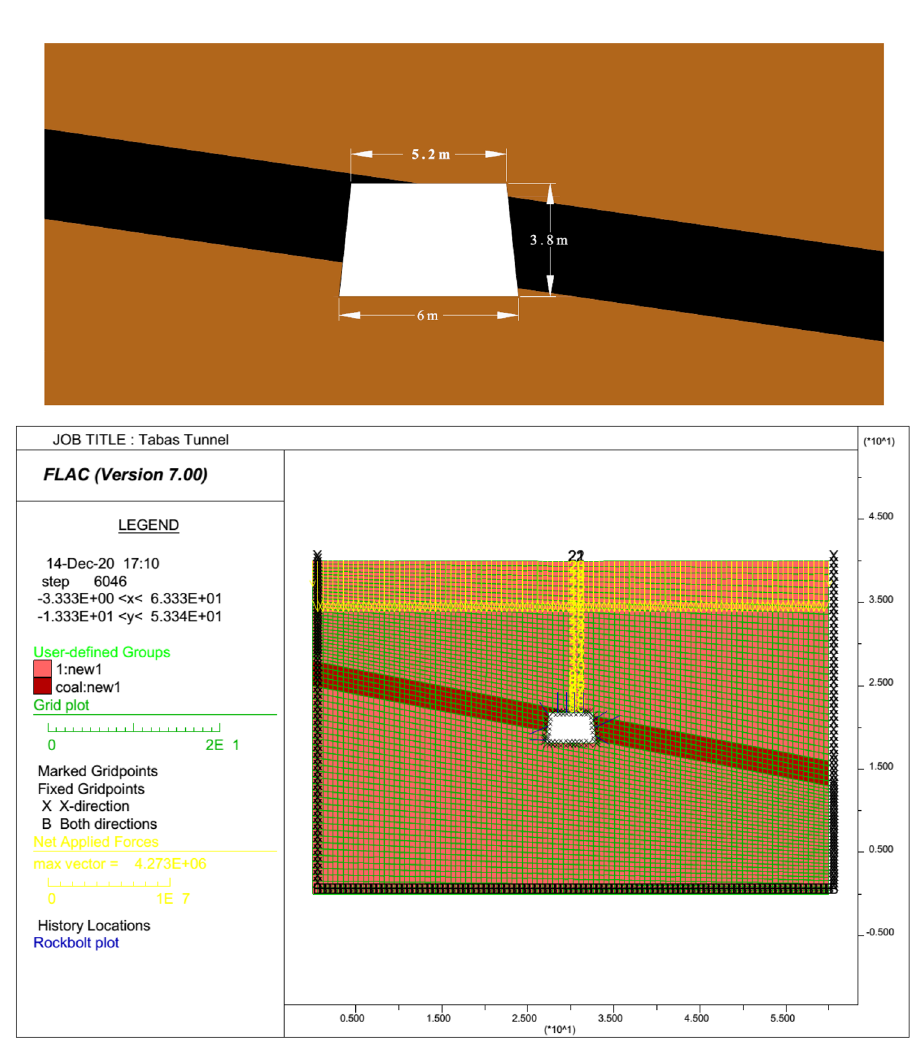
Figure 6. Geometry of the longwall tailgate modeled in FLAC